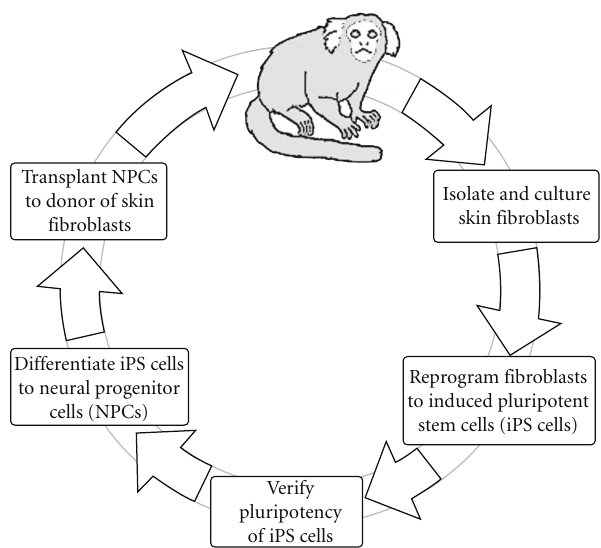
Figure 1: The marmoset as a preclinical model for patient-specific iPS cells in regenerative medicine. This scheme outlines progress to date and future studies of autologous cell transplantation using reprogramming and redi ff erentiation to a specific cell lineage. A skin biopsy is taken from an individual marmoset, and fibroblasts from the biopsy are grown in culture. Reprogramming factors are expressed in the cells; over a period of several weeks, clones of cells arise that may be iPS cells. Clones are isolated and screened to determine whether they are properly reprogrammed iPS cells; if so, they are expanded and cryopreserved. Neuronal progenitor cells (NPCs) are derived from these iPS cells via protocols described in the text. If the NPCs pass stringent tests of di ff erentiation potential and safety, in the future they may be implanted into the CNS of the same individual from which the cells were originally